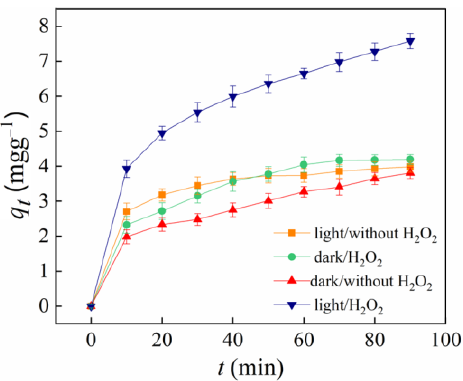
Figure 9. Adsorption/catalytic performance of n-hemin/PAN in different reaction conditions: dark/without H 2 O 2 , light/without H 2 O 2 , dark/H 2 O 2 , and light/H 2 O 2 .